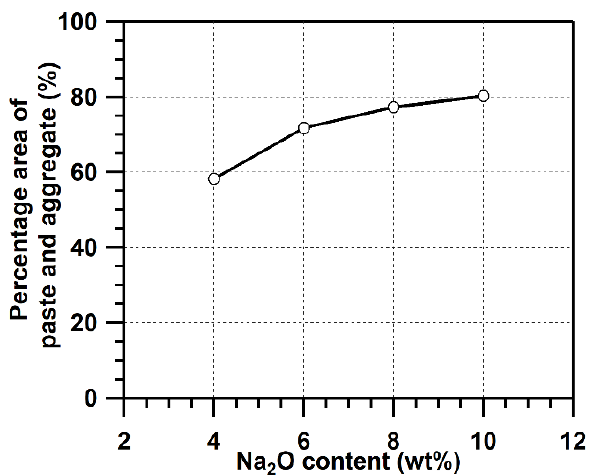
Figure 12. Sedimentation degree (as percent area of paste and aggregate) on the bottom of pervious concrete with different water glass content.